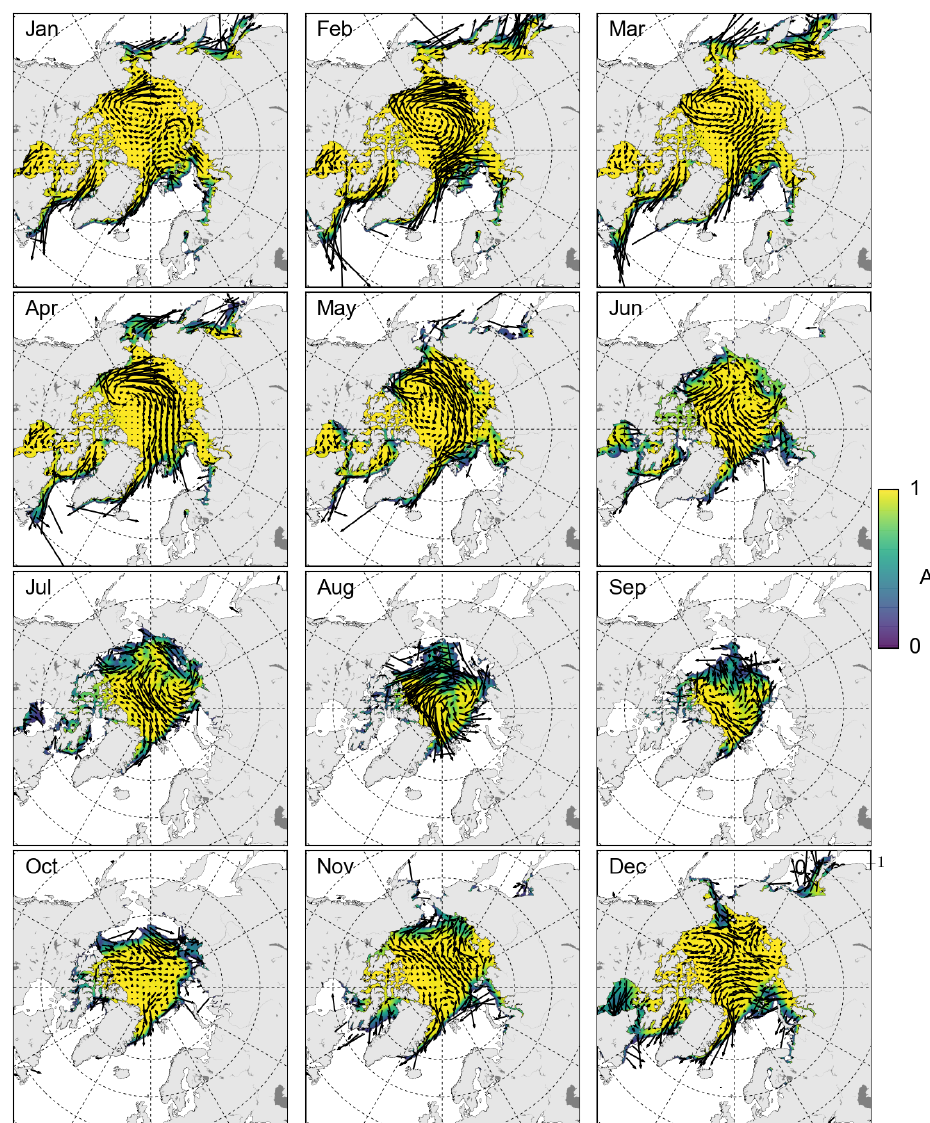
Figure 1. Monthly 2016 Arctic sea ice concentration using the Bootstrap algorithm, overlaid with the monthly mean KIMURA ice drift vectors (every third drift vector shown). The concentrations below 0.15 have been